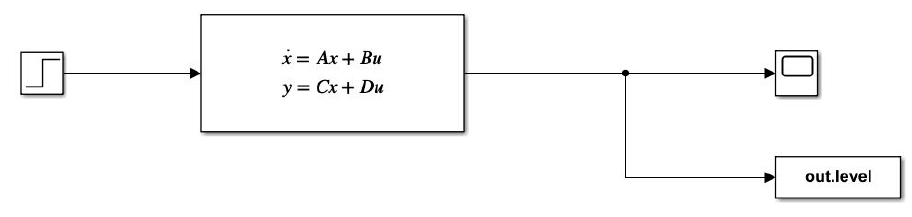
Figure 10. State-space system using Simulink.